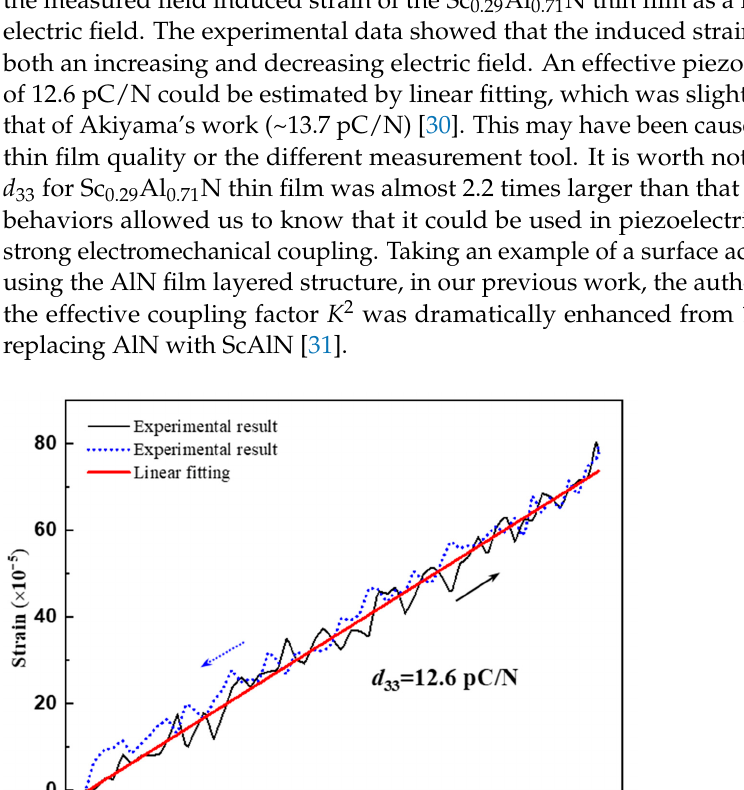
Figure 6. The measured field-induced strain of the Sc 0.29 Al 0.71 N thin film as a function of an applied electric field.